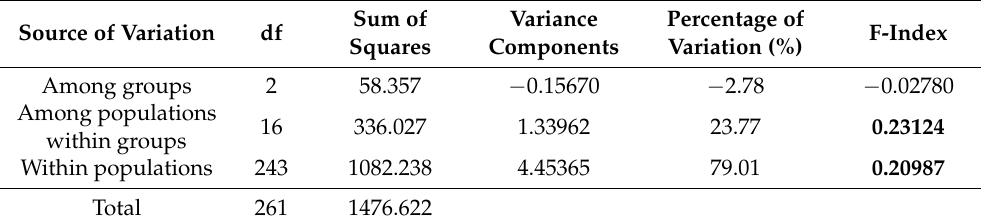
Table 3. Hierarchical analysis of molecular variance (AMOVA) for Aedes albopictus based on 16 microsatellite